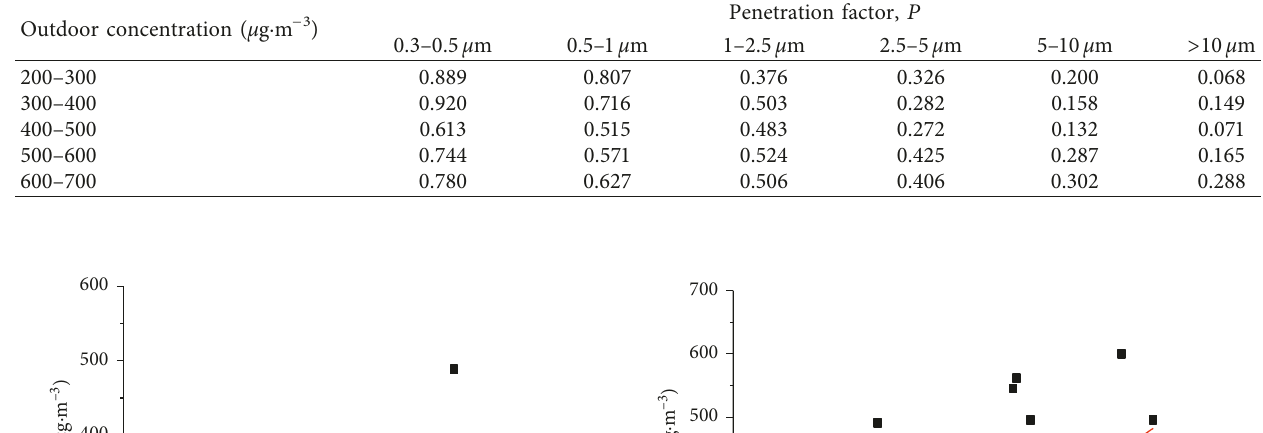
Table 3: Penetration factor of particles with different particle sizes under each outdoor condition.